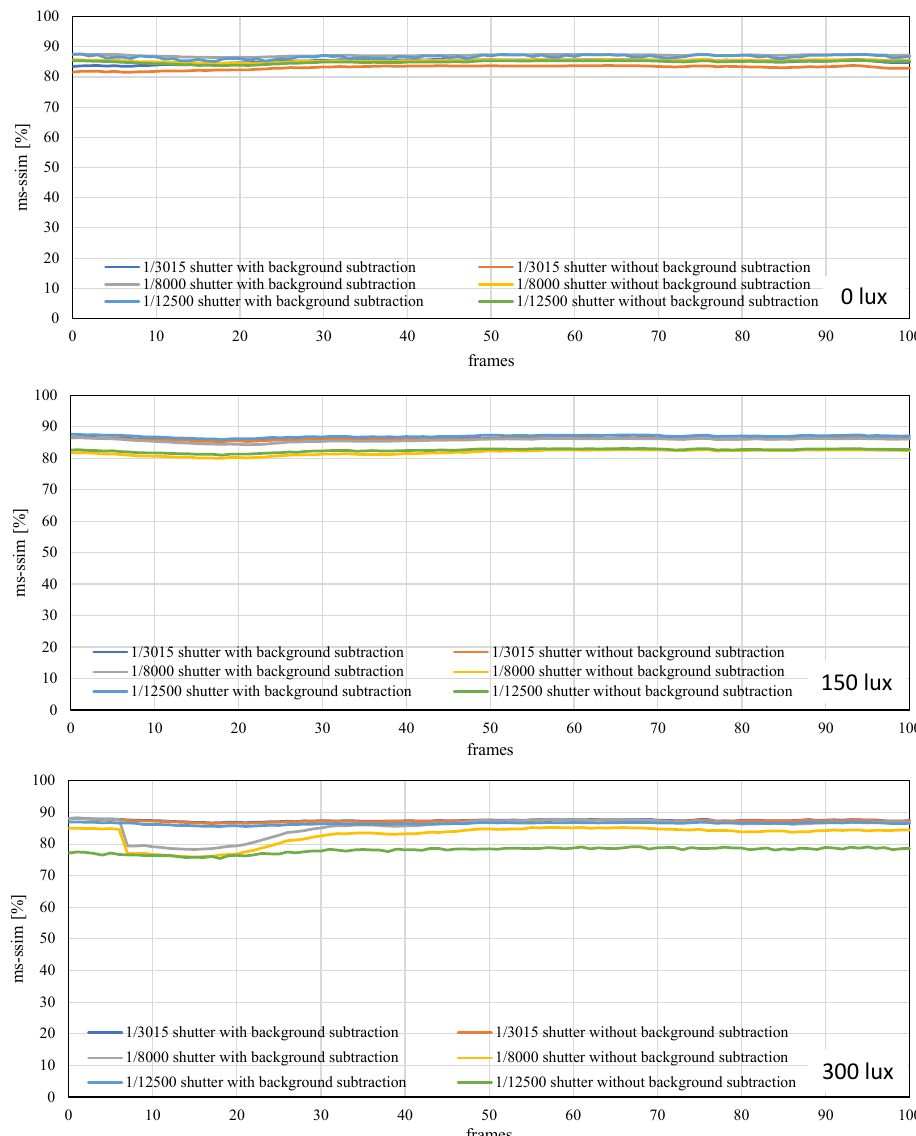
Figure 20. MS-SSIMs when a stored video sequence is streamed with pure binary-code and gray-code images on patterned background.